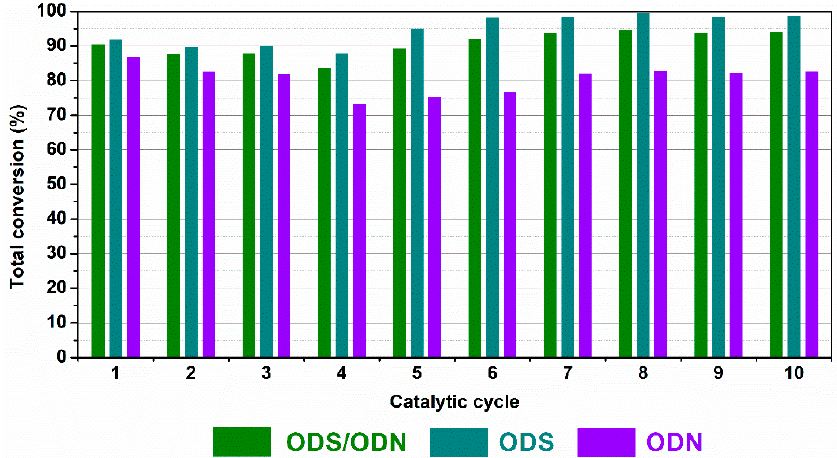
Figure 4. Reutilization performance of [BMIM] 3 PMo 12 @ZIF-8 over 10 cycles combining desulfuriza-